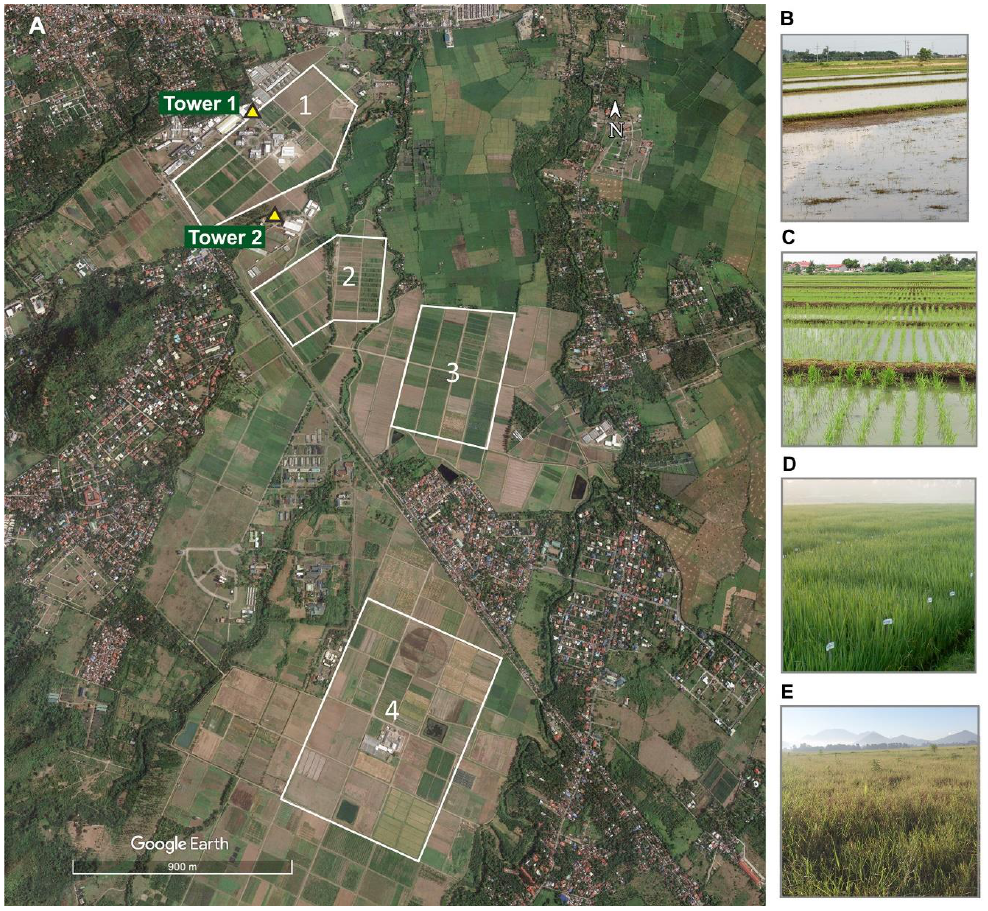
Figure 2. Map of IRRI’s research farm with the four sampling areas indicated ( A ). Yellow triangles indicate the location of two 50 m-tall radio towers on which ultrasonic detectors were mounted. Representative photos of the Water ( B ), Early ( C ), Late ( D ), and Grass ( E ) stages of rice cultivation